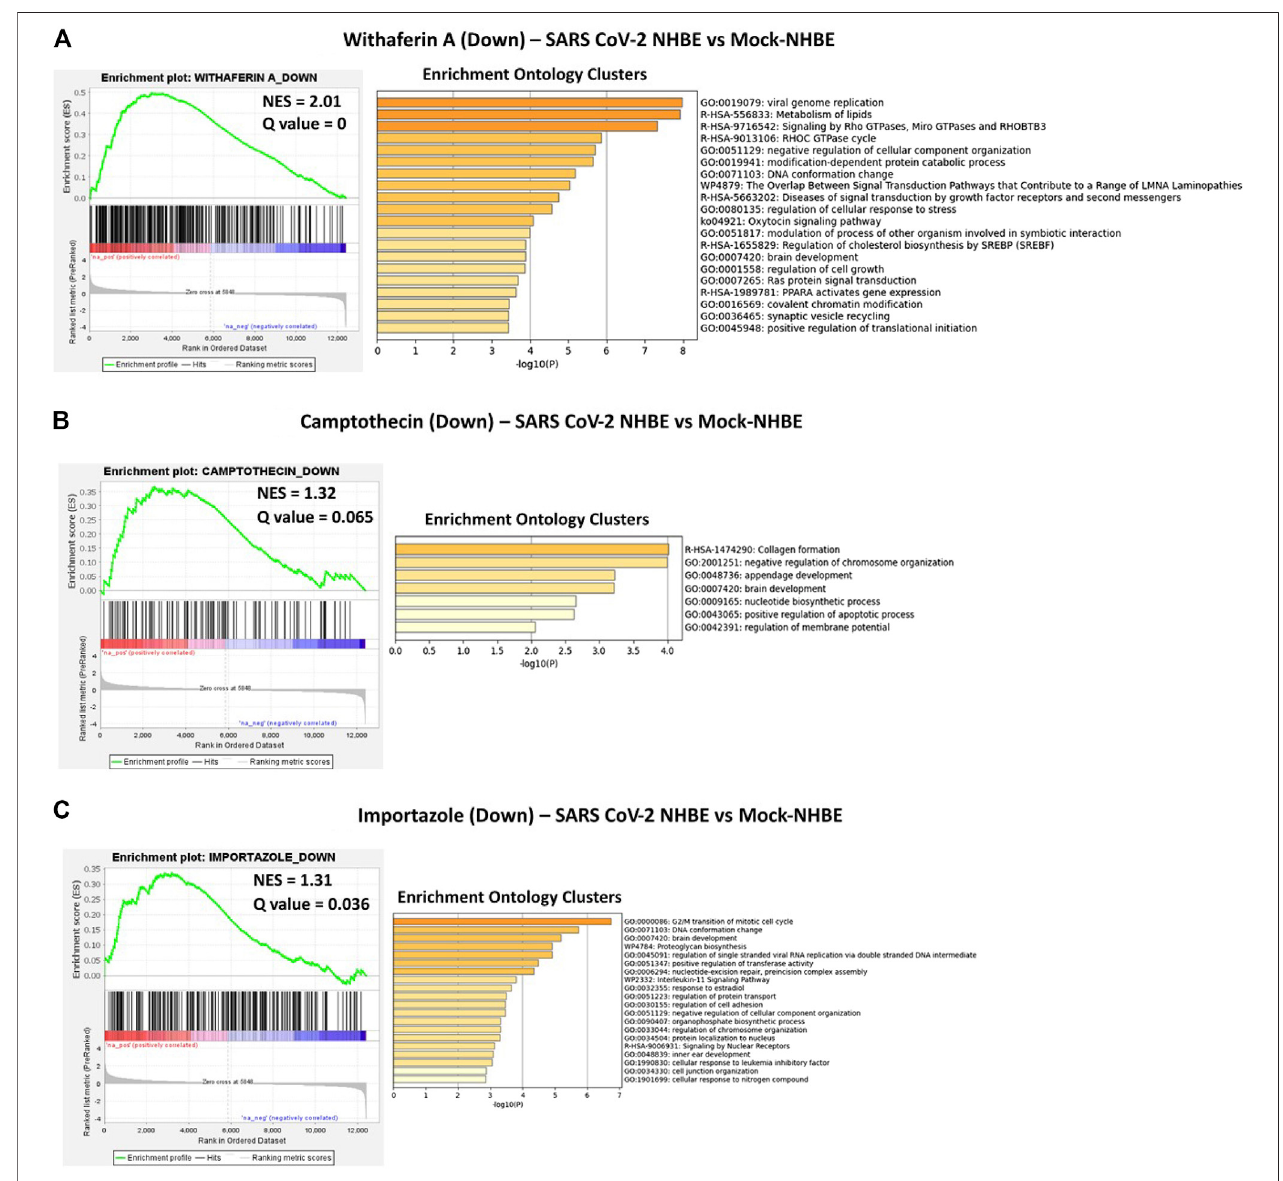
FIGURE 5 | GSEA preranked analysis was performed to decipher the potential gene signatures downregulated by camptothecin, importazole, and withaferin A using theRNK fi le generated from DEGs of SARSCoV2-NHBEvs. Mock-NHBEcomparison.The Metascapeanalysestodecipher thegene ontology clustersbased on the (A) enrichment of gene signature (Signature ID: CPC014_VCAP_6H: BRD-A52193669:10.0) downregulated by withaferin A (B) enrichment of gene signature (Signature ID: CPC002_PC3_24H: BRD-A30437061:10.0) downregulated by camptothecin, and (C) enrichment of gene signature (Signature ID: CPC006_A375_24H: BRD-A02481876:60.0) downregulated by importazole in SARS CoV2-NHBE cells.